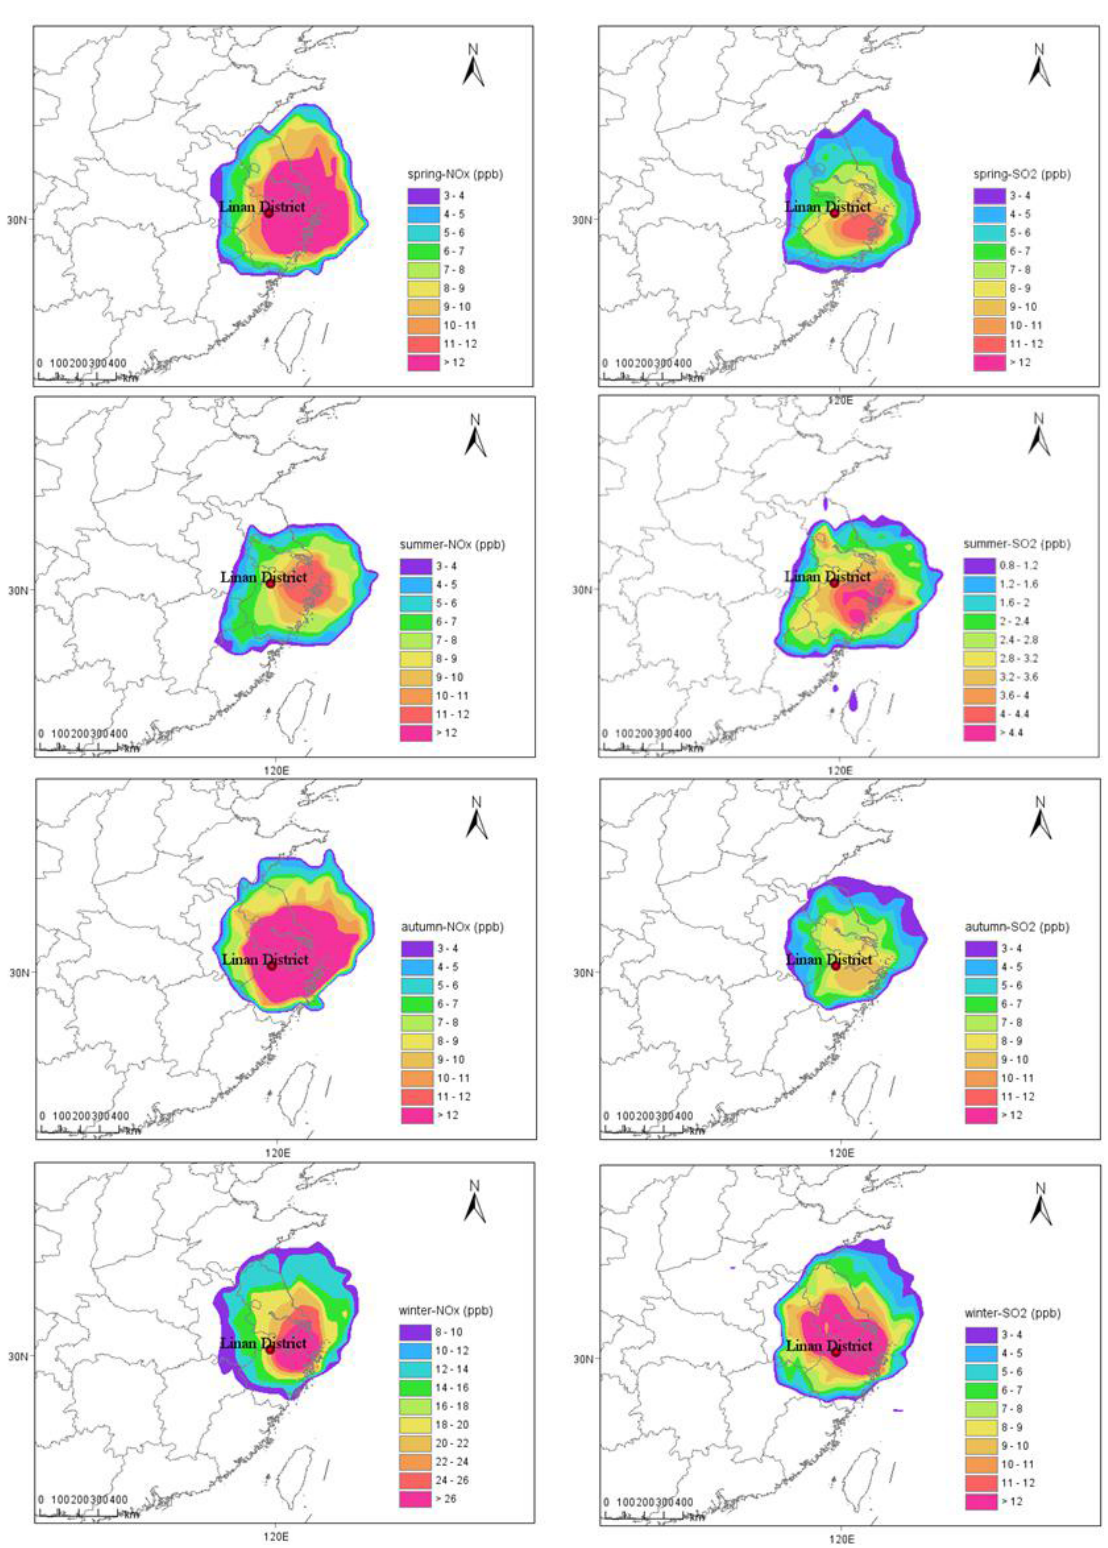
Figure 7. Potential source analysis of NO x and SO 2 in different seasons at LAN according to concentration-weighted trajectory analysis.